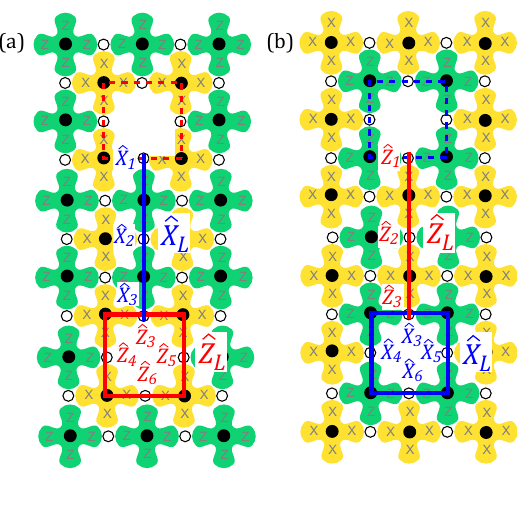
Figure 29: (a) A double Z-cut and (b) a double X-cut qubit, formed by turning off two measure- Z and two measure-X qubits, respectively. For the double Z-cut qubit the logical operators are = X X X X , a chain that links one Z-cut hole’s internal X boundary to the other, and a L 1 2 3 = Z Z Z Z Z loop that encloses the lower Z-cut hole. For the X-cut qubit, Z L 3 4 5 6 a chain that links the two internal X-cut holes’ Z boundaries, and X